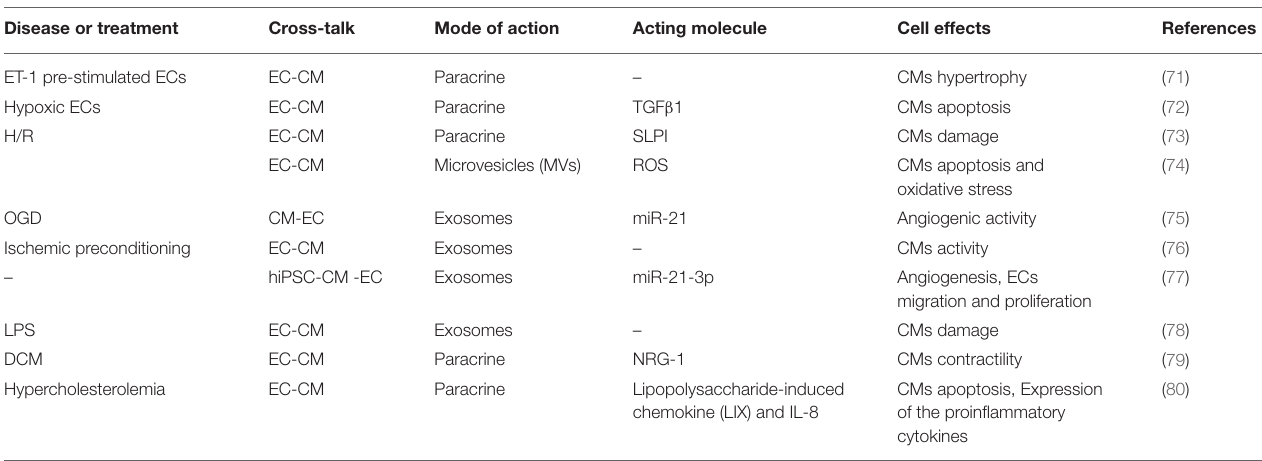
TABLE 2 | Table of EC-CM and CM-EC interactions in the cardiovascular field. Disease or